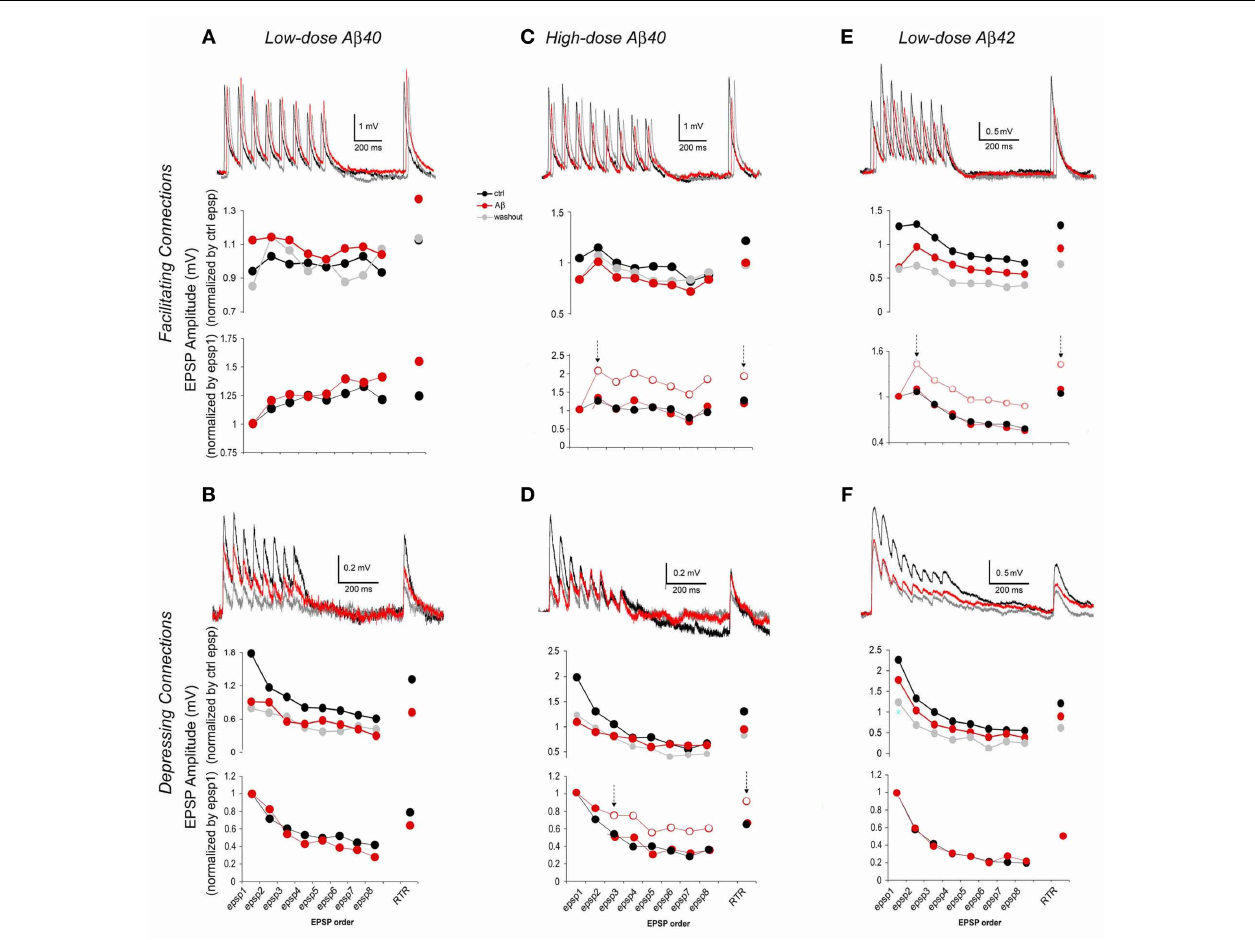
FIGURE 3 | EPSP trains of F- and D- connections change differentially depending upon the synapse type and the A β species and